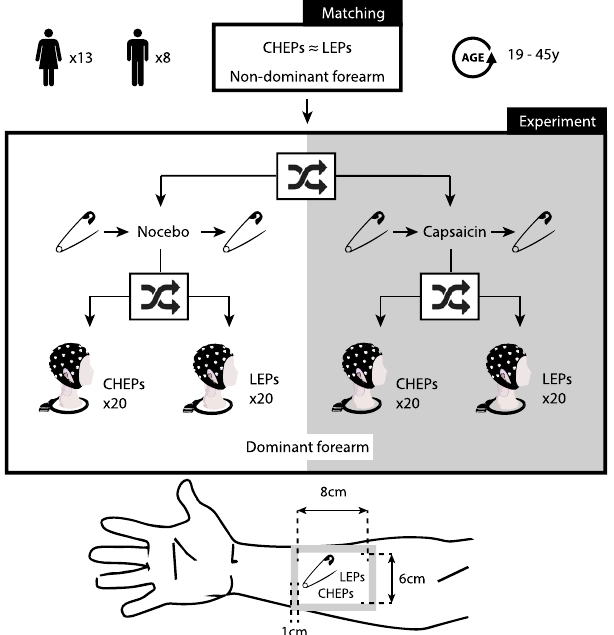
Figure 1. Study design. Subjects first underwent an intensity-matching protocol on the non-dominant forearm (upper box). Using a stair-case paradigm, CHEPs and LEPs were matched for stimulation intensity based on individual perception. Subsequently, subjects were randomized to the capsaicin (white background) or sham (gray background) group. Both experimental groups started with the assessment of pain sensation using pinprick stimulation within the confirmed secondary hyperalgesia area on the dominant volar forearm. After 30 min of topical application (sham or capsaicin), the pinprick protocol was repeated and then 20 laser or contact heat stimulations were applied. Brain responses to contact heat and laser stimulations applied in the secondary hyperalgesia area were recorded with a 32-channel EEG set up. Subjects were exposed to all four conditions in a randomized order. The volar forearm at the bottom is an illustration of the 1 ml capsaicin or sham cream application (gray perimeter with 1 cm width). The measured pinprick, laser and contact heat site is the inner square with the size of 6 × 8 cm (expected area of secondary hyperalgesia) and is centered to the forearm (wrist to